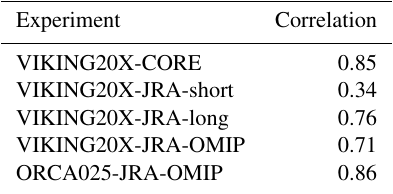
Table 4. Correlations of the annual mean gyre index with observa- tions for the period 1993–2009. Correlations are significant at 99%, except the one for VIKING20X-JRA-short